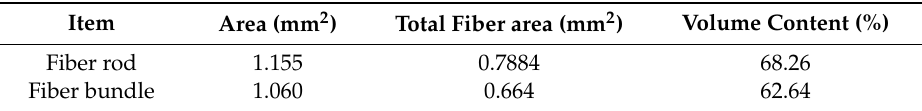
Table 3. Volume content of fiber reinforced phase in axially braided C / C composites (The data obtained from the observation of 100